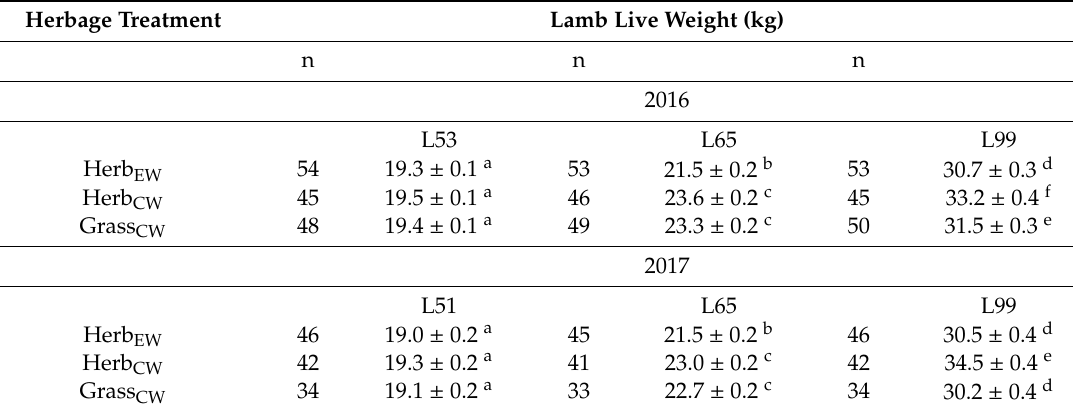
Table 2. Live weight of lambs in Herb EW , Herb CW and Grass CW treatments at L53, L65 and L99 in 2016 and at L51, L65 and L99 in 2017 (least-squares mean ± SEM).